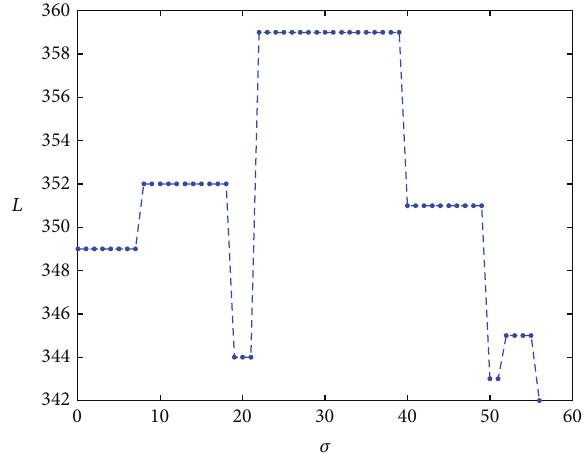
Figure 1: CDS-based enumerative shifting procedure: behavior of virtual array aperture 𝐿 versus evaluated shift 𝜎 for CDS-based MR- MIMO array ( 𝑀 = 8 , 𝑁 = 4